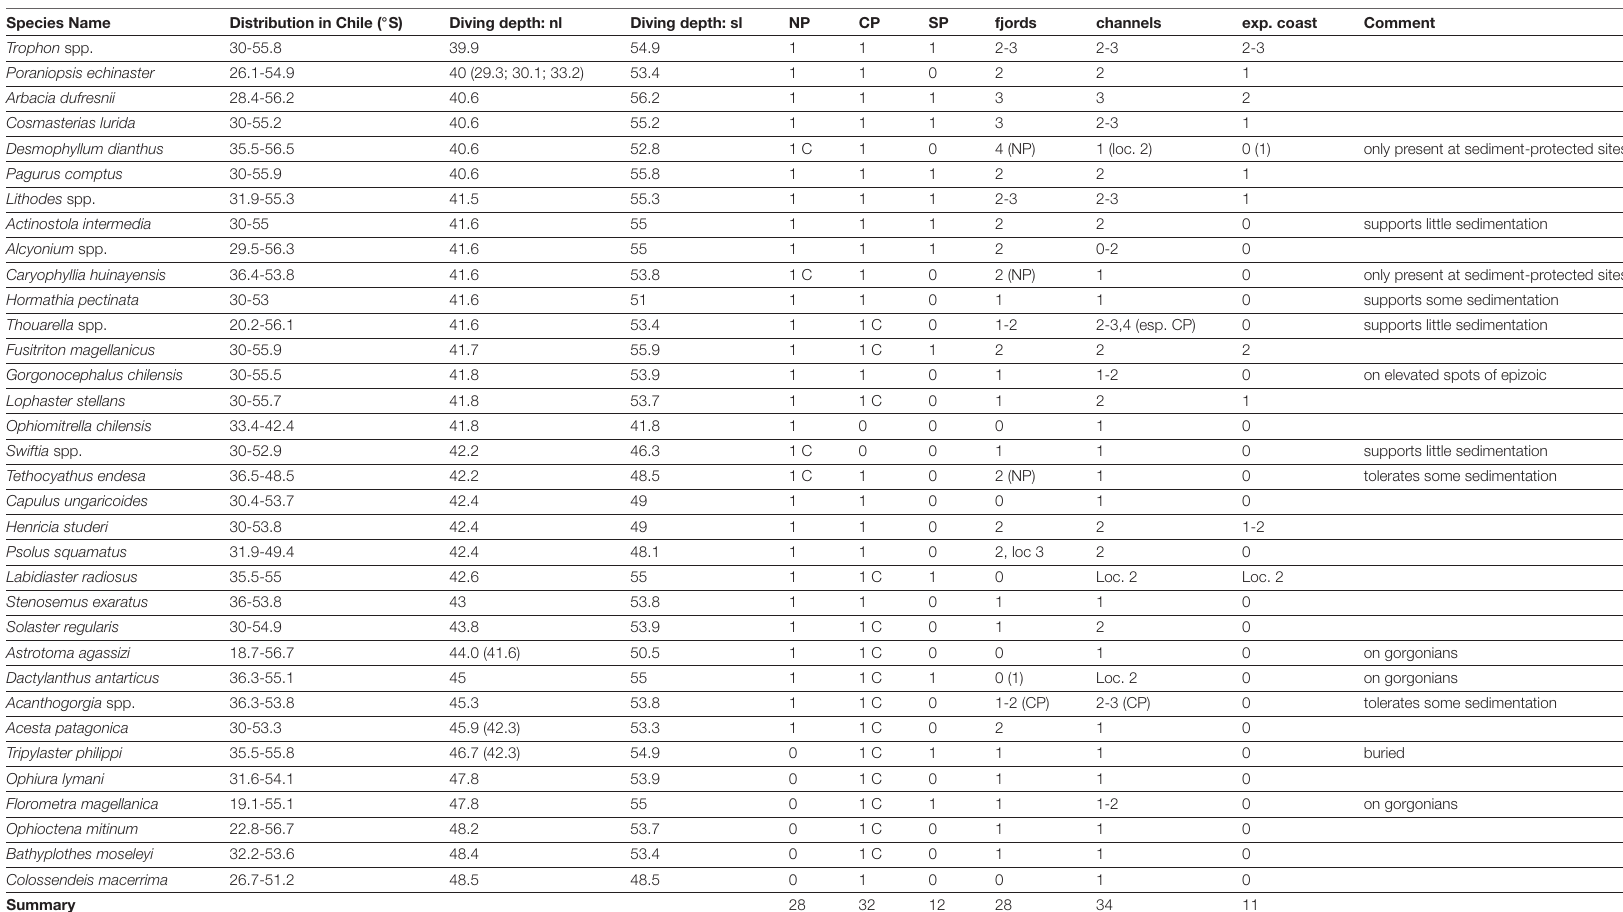
TABLE 2 | Deep-water emergent species within diving depths in Chilean Patagonia (nl, northern limit; sl, southern limit), sorted by appearance from north to south, including summary of their presence in North Patagonia (NP), Central Patagonia (CP), and South Patagonia (SP), and in fjords, channels and at the exposed